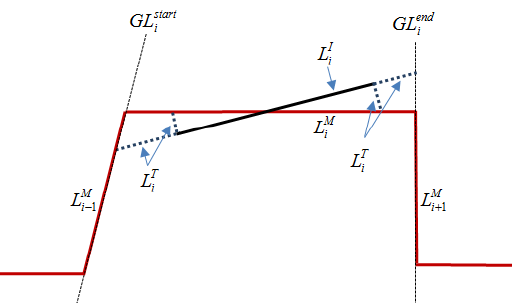
Figure 2. Establishment of topological relations between I-Line and L-Model For hypothesis generation.